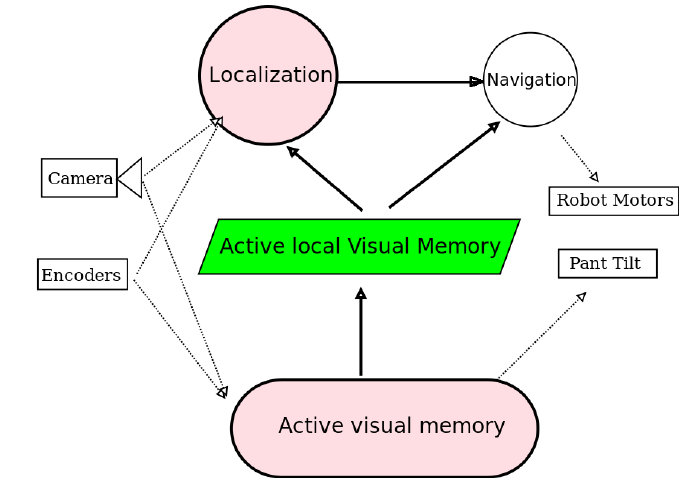
Figure 1. Block diagram of the proposed visual